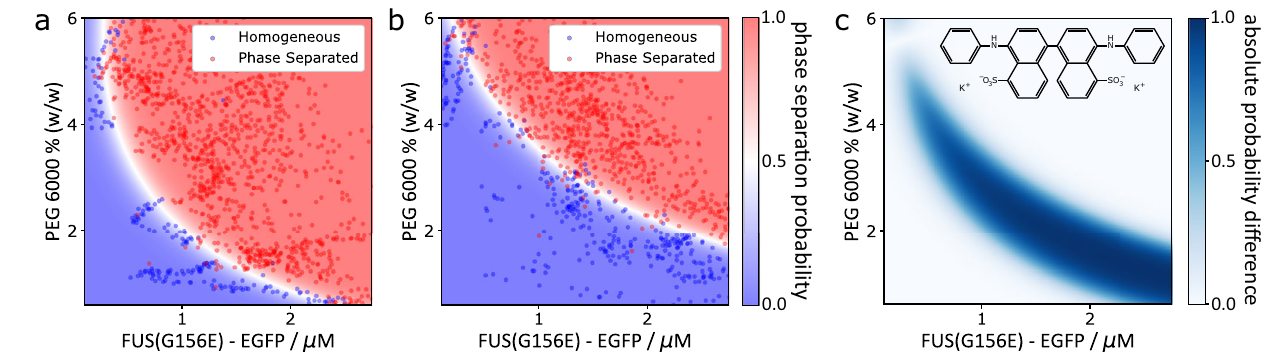
Fig. 3 | Probing the effect of small molecule modulators on phase separation using PhaseScan. a Phase diagram of EGFP-tagged FUS G156E vs. PEG 6000 concentration in the absence of bis-ANS. N =1616 droplets. b Phase diagram of EGFP-tagged FUS G156E vs. PEG 6000 concentration in the presence of bis-ANS. N =2559 droplets. c Molecular structure of bis-ANS and differential